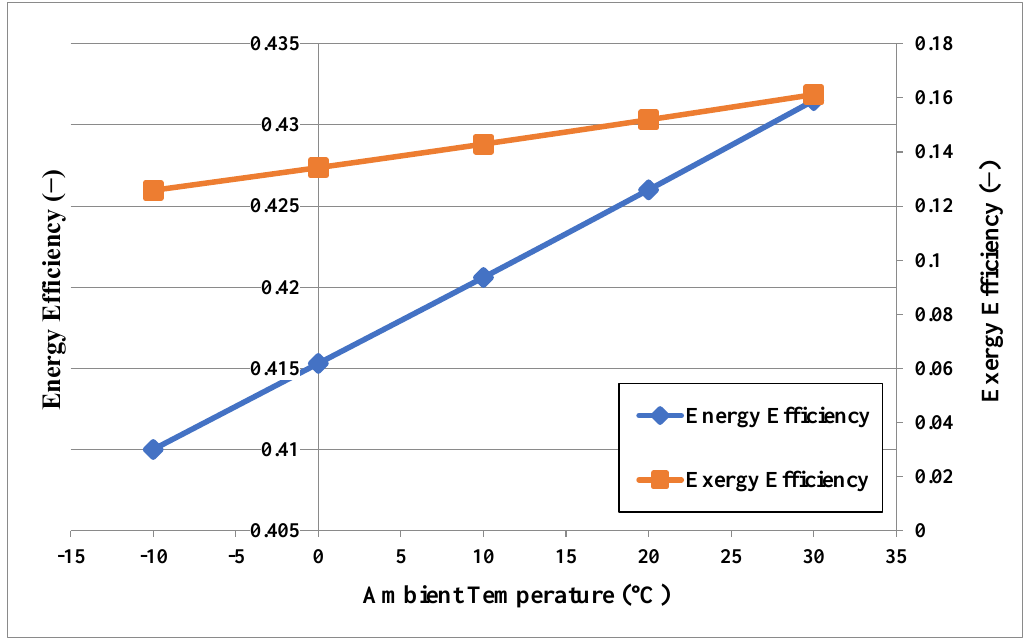
Figure 8. Energy and exergy efficiencies versus the flow rate of the hot water. Table 3 provides the decision variables that influence the objective function along with acceptable values to maximize the exergy and energy efficiencies at the same time.